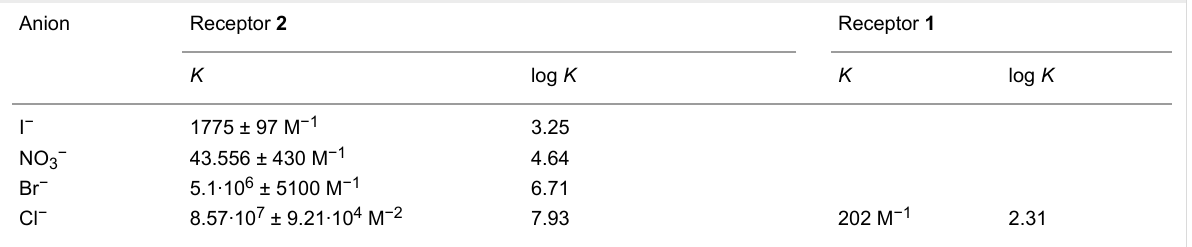
Table 1: Binding constants of the macrocyclic bis(ureas) 1 and 2 towards different anions. All anions were used as tetrabutylammonium salts. Com- pound 2 was dissolved in THF- d 8 and 1 in DMSO- d 6 . All NMR spectra were taken at room temperature (298 K).